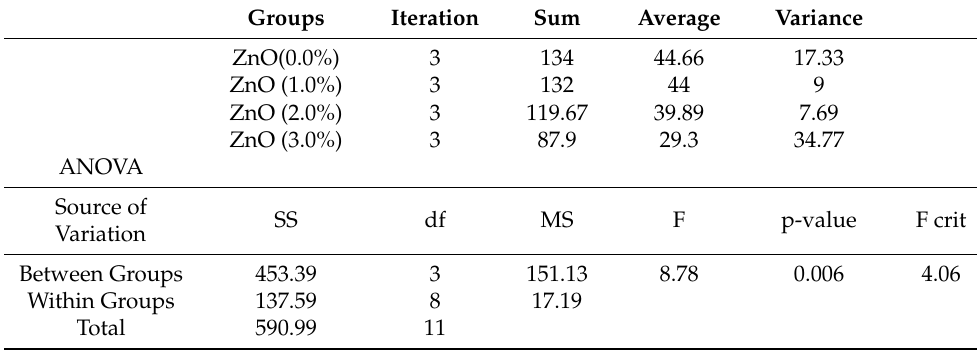
Table 5. Water Absorption values of ZnO-UF MDF for different iterations. Groups Iteration Sum Average Variance